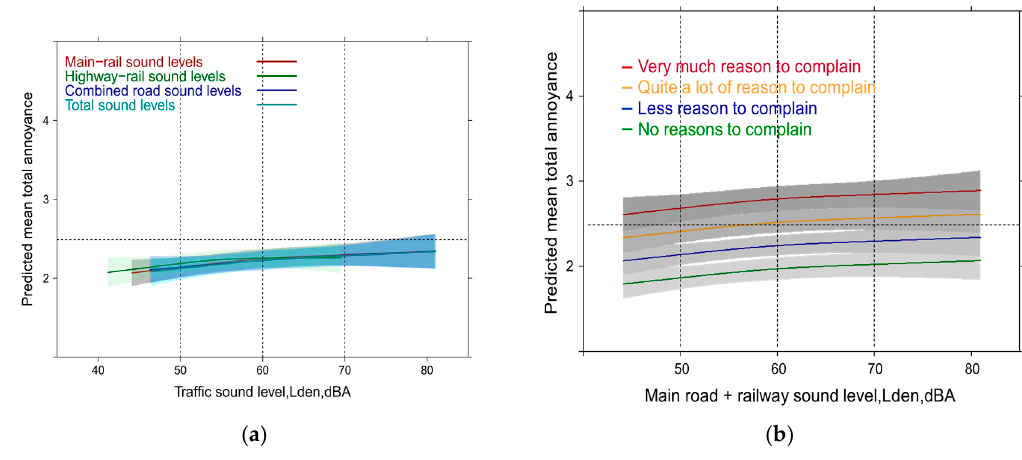
Figure 15. ( a ) Predicted mean total annoyance associated with multiple source combinations; ( b ) Predicted mean total annoyance associated with the largest single predictor (dissatisfaction with community soundscape) main road-rail combination. Adjusted for age, sex, education, noise sensitivity, health status, the other sound sources, anger at traffic load, perceived vibration and perceived dust/soot from traffic, complaints about air pollution at the community level and complaints about community soundscape (not b ). Horizontal line = mean total annoyance.